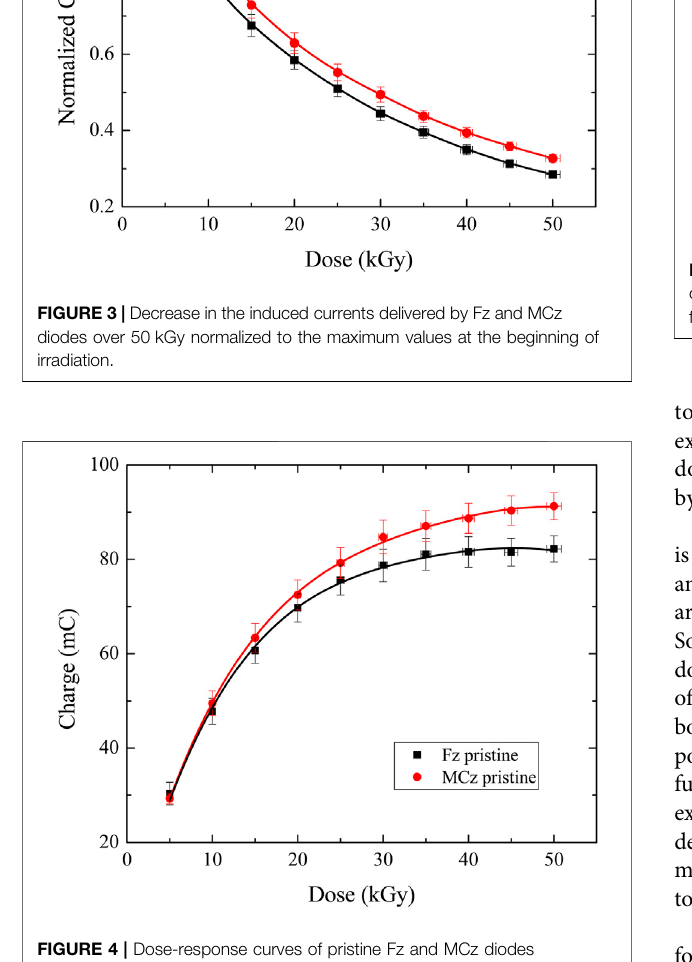
FIGURE 4 | Dose-response curves of pristine Fz and MCz diodes coveringthedoserangeof50 kGy.Afourth-orderpolynomialfunctionbest fi ts the data.